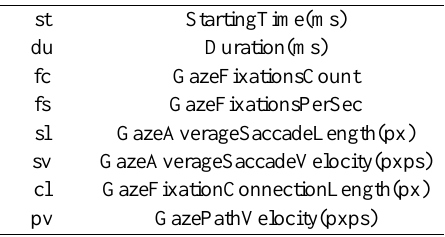
Table 2 Selected variables for data analysis